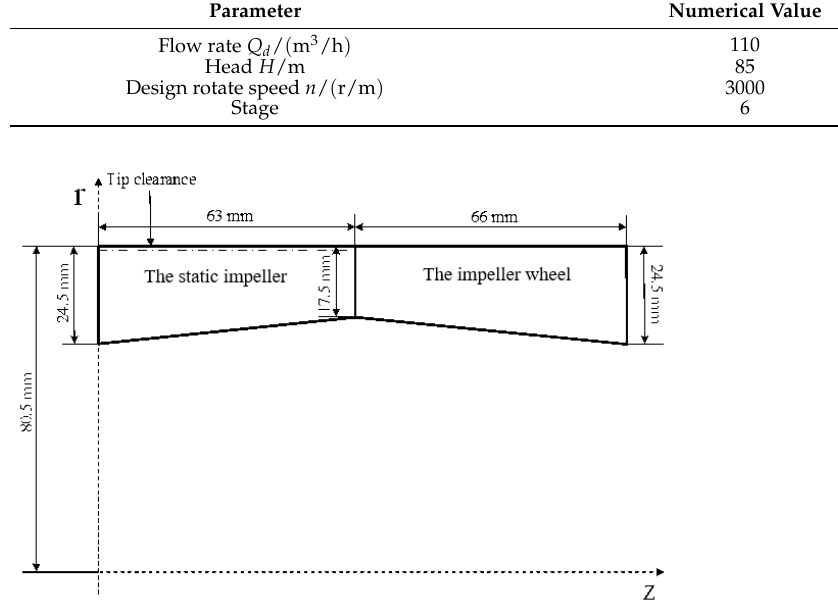
Figure 1. Impeller and diffuser meridian parameters.